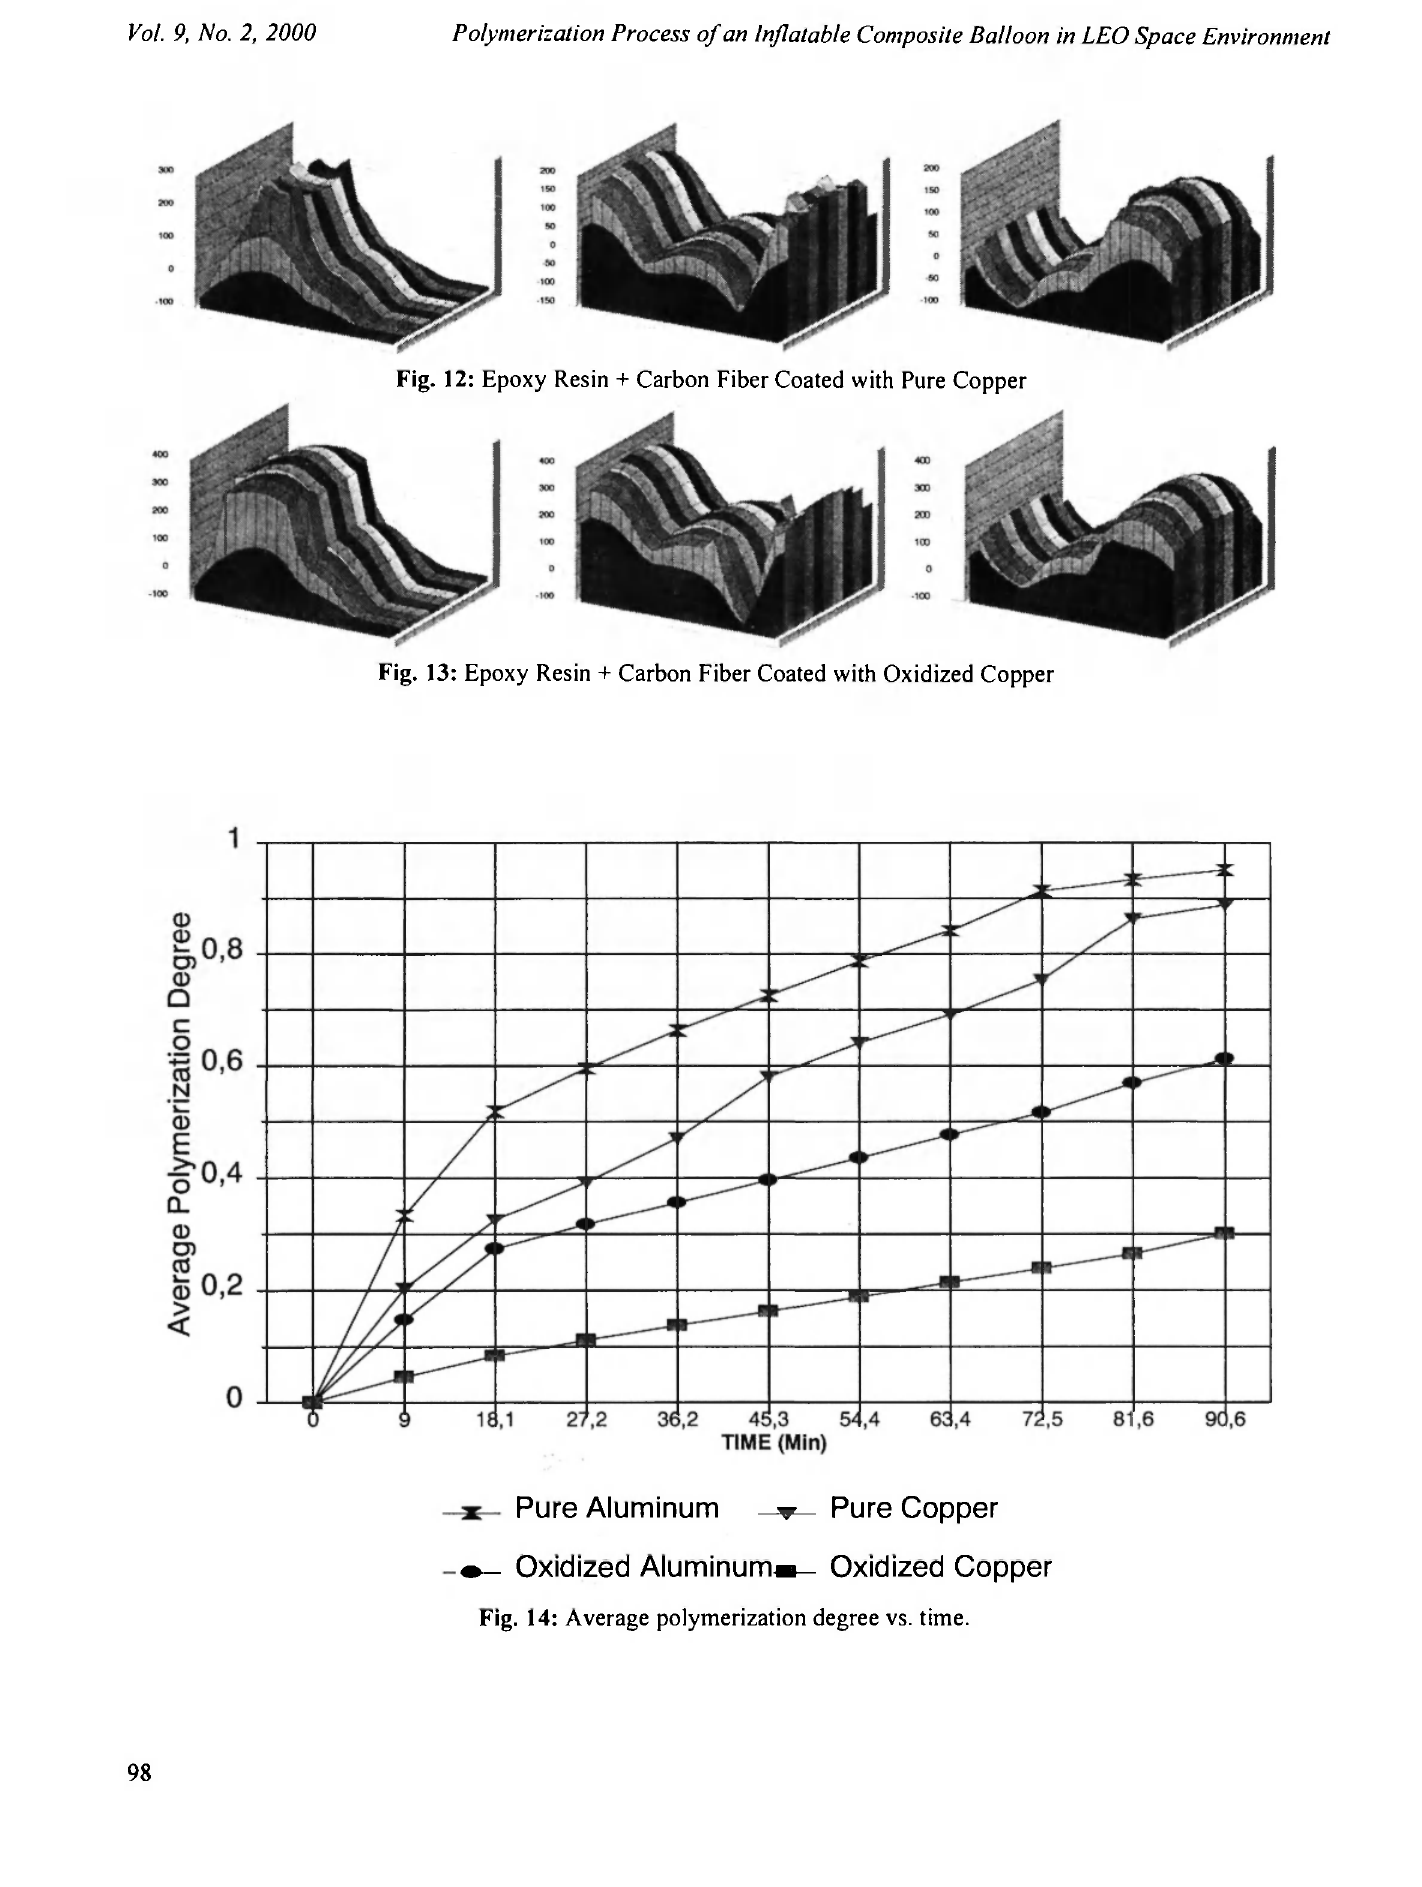
Fig. 14: Average polymerization degree vs.